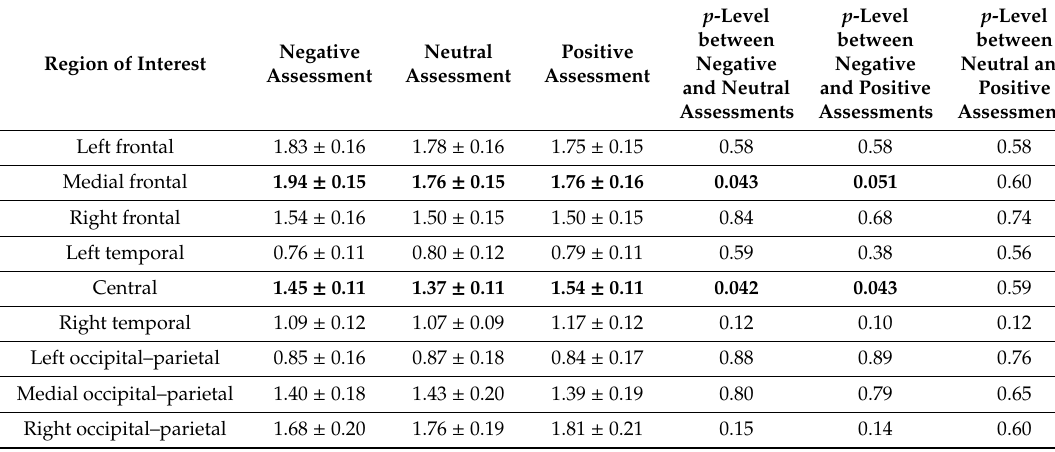
Table 3. The di ff erences in the P300 maximal amplitude (in µ V) between various assessments among cortical regions. Significantly di ff erent values are in bold.